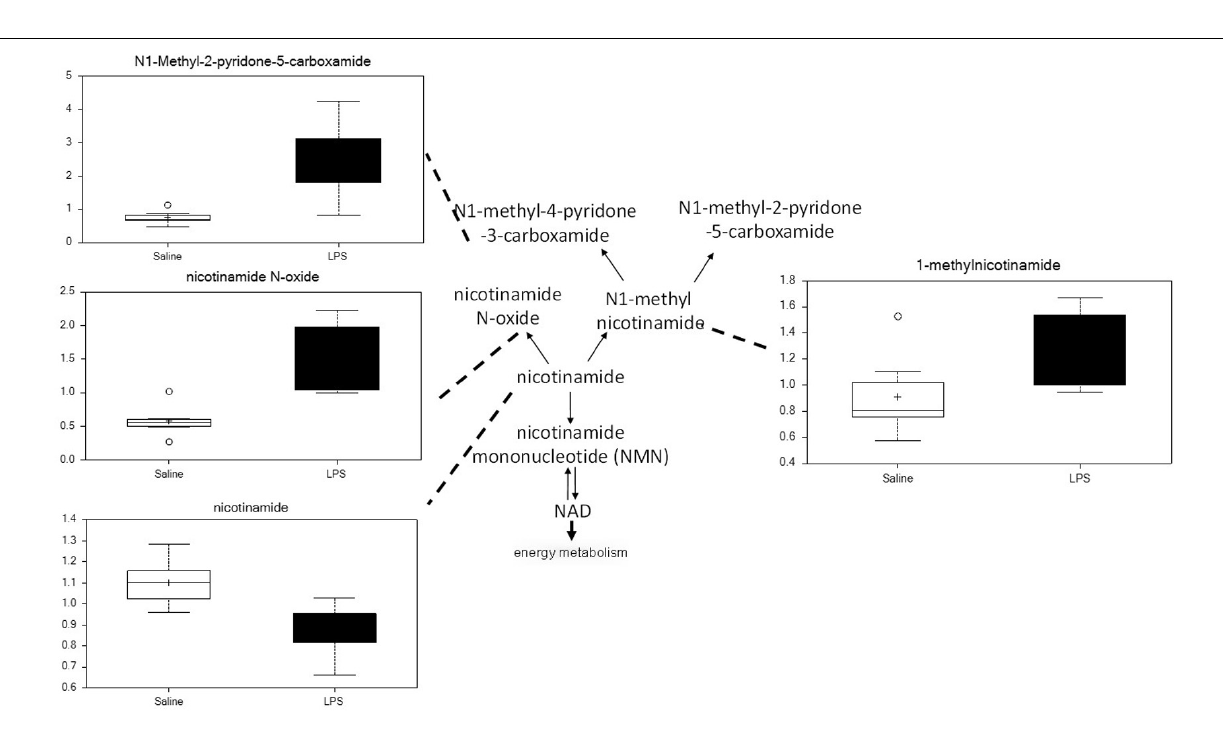
sphingosine-1-phosphate signaling and the PI3K/AKT/PTEN signaling pathway. Spingosine-1-phosphate signaling controls vascular tone, permeability, and modulation of α 1 -adrenergic